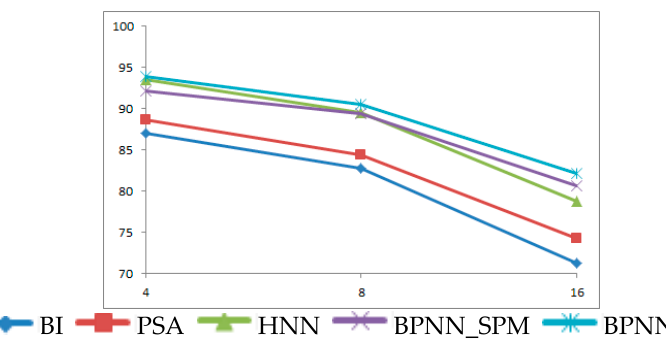
Figure 8. Performance of the five methods with 4, 8, and 16 scale factors for synthetic data.